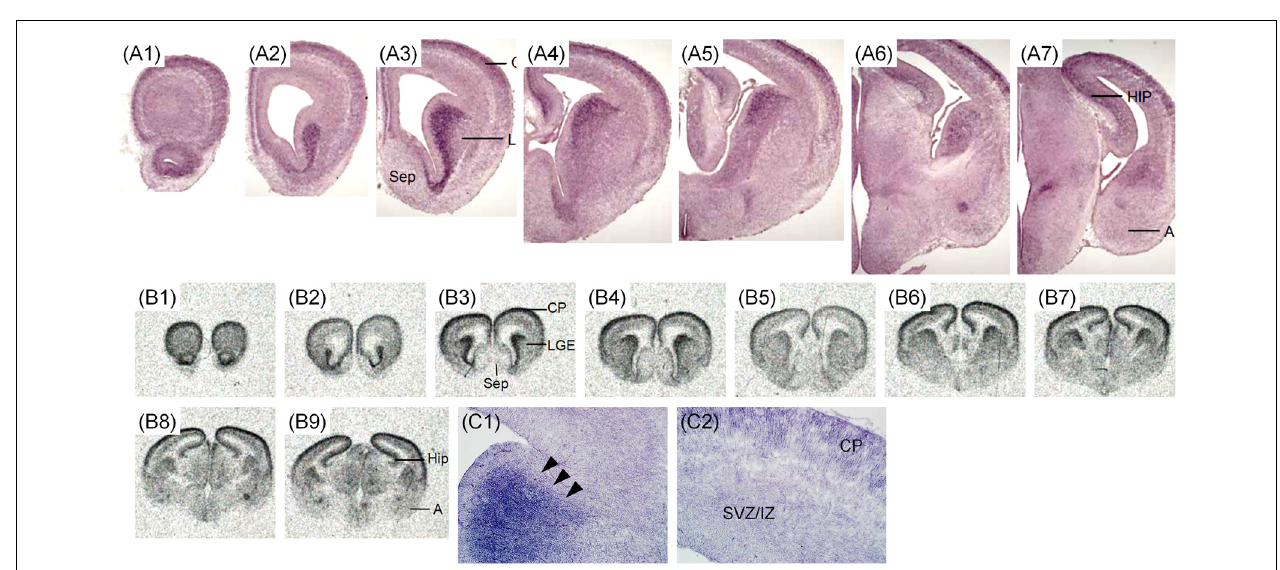
FIGURE 3 | Zswim6 mRNA expression pattern in E13.5 mouse forebrain. Expression pattern of Zswim6 mRNA detected by in situ hybridization with digoxigenin-labeled probes (A1–A6) and 35 S-labeled probes (B1–B9) from rostral to caudal levels. (C) Zswim6 is strongly expressed in the SVZ of LGE (C,C1) . Weak expression of Zswim6 is present in the SVZ of MGE (C,C2) . A, amygdala; CGE, caudal ganglionic eminence; CP, cortical plate; FF, Fields of Forel; H, hypothalamus; LGE, lateral ganglionic eminence; MGE, medial ganglionic eminence; MZ, mantel zone; SVZ, subventricular zone; VZ, ventricular zone.